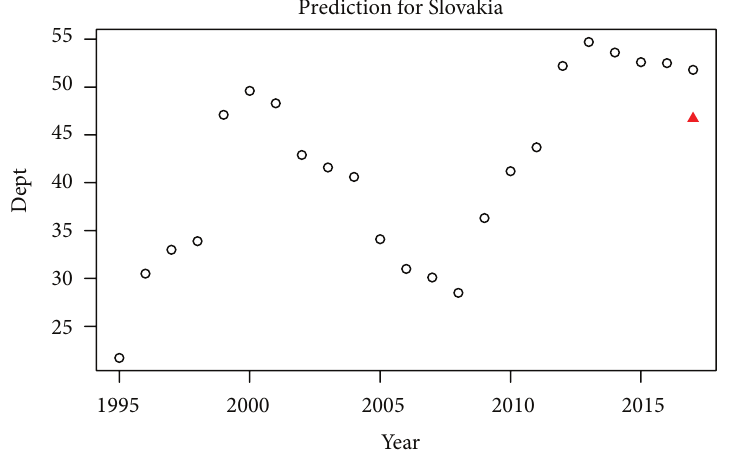
Figure 3. Development of public debt from 1995 to 2017, including prediction for 2017 (source: own data processing in R